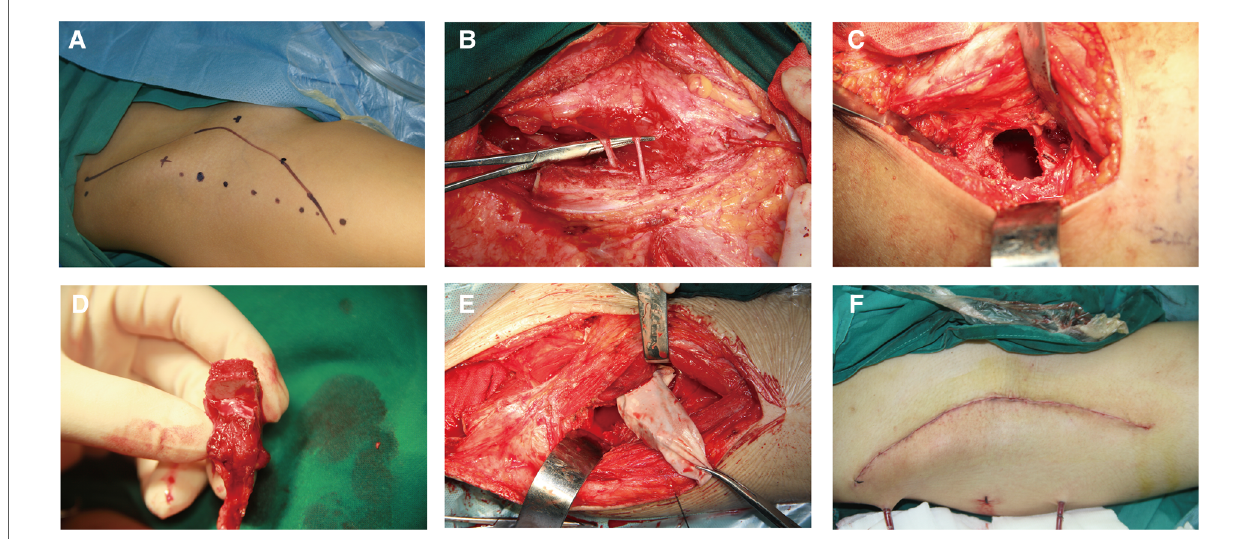
FIGURE 1 Surgical step. ( A ) A Smith – Petersen incision was designated through the groin to the thigh to expose the donor site for harvesting a pedicled iliac bone fl ap and the necrotic femoral head. ( B ) The skin and subcutaneous tissue were dissected, and the lateral femoral cutaneous nerve was exposed and protected. ( C ) The bone window was designed on the proximal femoral neck. ( D ) The pedicled iliac bone fl ap based on the deep circum fl ex iliac artery was harvested and con fi rmed by punctate bleeding points from the osteotomy side. ( E ) The transferred pedicled iliac bone fl ap was put in a sterile glove and transported through a tunnel under the rectus femoris and inguinal ligament. ( F ) The incision was closed layer by